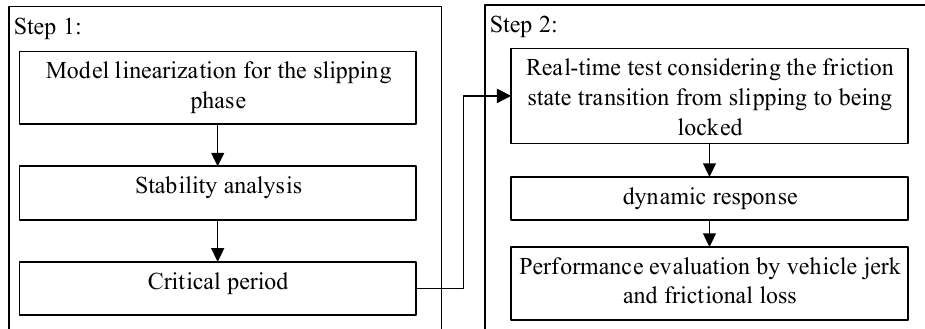
Figure 1. Two-step framework of the proposed control–scheduling co-design.